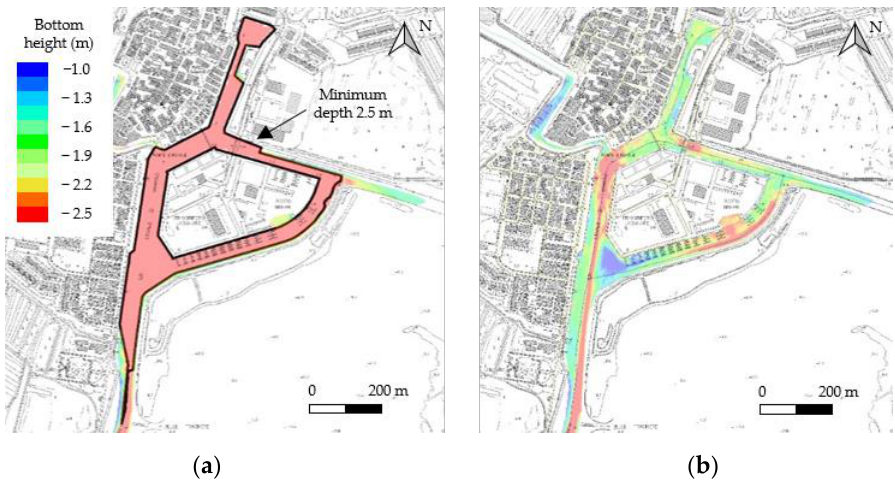
Figure 3. Consecutive surveys in the port: bottom height superimposed onto regional cartography from 2003. ( a ) Bottom height after the dredging works in 2015; the black line indicates the area where a minimum water depth of 2.5 m is guaranteed; ( b ) Bottom height in 2019.